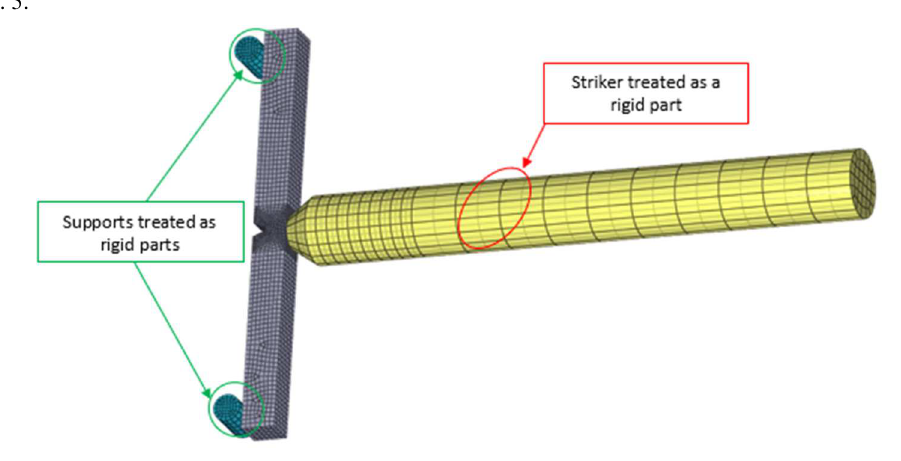
Fig. 5. Generic computing model used for all dynamic